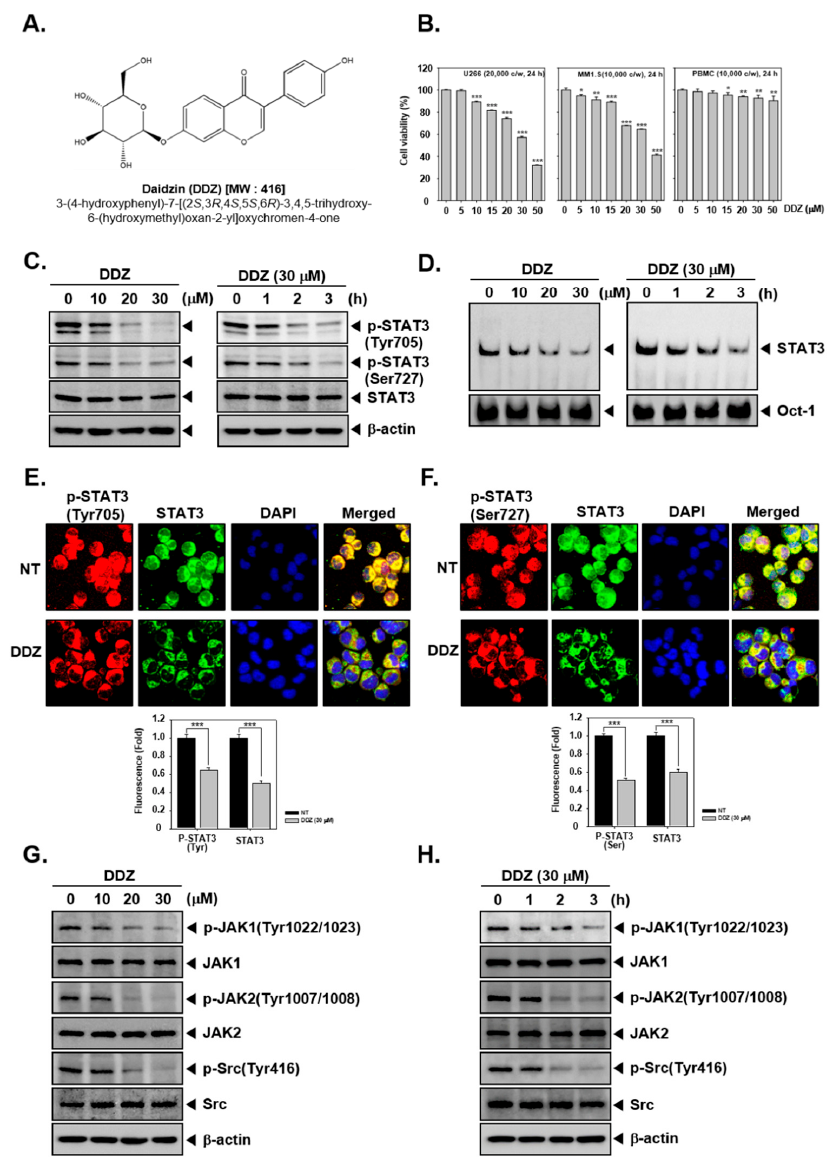
Figure 1. Daidzin (DDZ) suppresses constitutive STAT3 (signal transducer and activator of transcription 3) activation in U266 cells. ( A ) The chemical structure of DDZ. ( B ) To determine the cell viability, a 3-(4,5-dimethylthiazol-2-yl)-2,5-diphenyltetrazolium bromide (MTT) assay was employed. U266 cells (2 × 10 4 cells / well) were treated with indicated concentrations for 24 h. ( C ) U266 cells were treated with dose dependent (0, 10, 20, and 30 µ M) or time dependent (0, 1, 2, and 3 h) conditions, and western blotting was done. ( D ) U266 cells were treated as described above in panel ( C ), and nuclear STAT3 levels were measured by an electrophoretic mobility shift assay (EMSA). ( E ) and ( F ) U266 cells (1 × 10 6 cells / well) were treated with 30 µ M of DDZ for 3 h, and intracellular p-STAT3(Tyr705) and p-STAT3(Ser727) distribution was analyzed by immunocytochemistry. ( G )–( H ) U266 cells (1 × 10 6 cells / well) were treated as described above in panel ( C ), and a western blot analysis was performed. The results shown are representative of three independent experiments. The results are presented as the mean ± SD. * p < 0.05, ** p < 0.01, *** p < 0.001 compared the